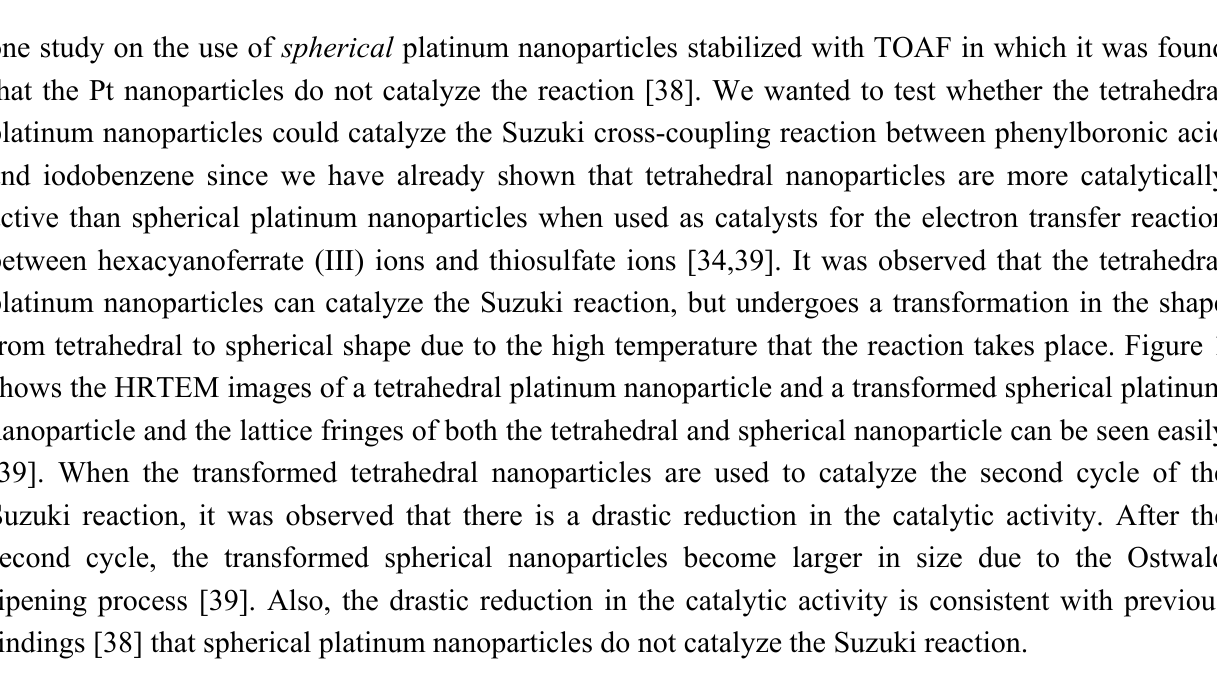
Figure 1. HRTEM image of a tetrahedral nanoparticle (a) and the transformed spherical platinum nanoparticle (b). Reprinted (“Adapted” or “in part”) from [39] with permission. © 2005 American Chemical